Question: In a single sentence, describe what this figure presents.
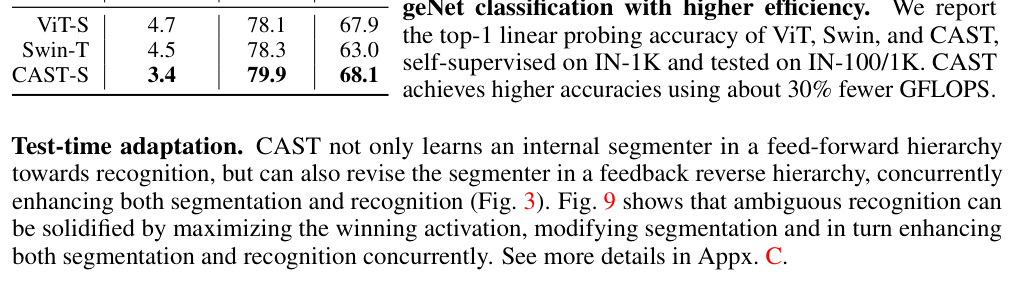
Answer: CAST can be adapted during test time to solidify ambiguous recognition and refine segmentation. For the binary dog classification task on PartImageNet shown in Fig. 3, We assess region mIoU on PartImageNet for CAST’s 8-way segmentation against the ground-truth dog mask before and after adaptation (Fig. 3). When the mIoU is initially lower than threshold 0.8 (vertical line), it has a large and positive gain mostly (red dots above the diagonal line). The average gain (black line) is large (zero) with poor initial segmentation when adaptation is most (not) needed. Our concurrent segmentation and recognition enhances each other in this adaptation process.